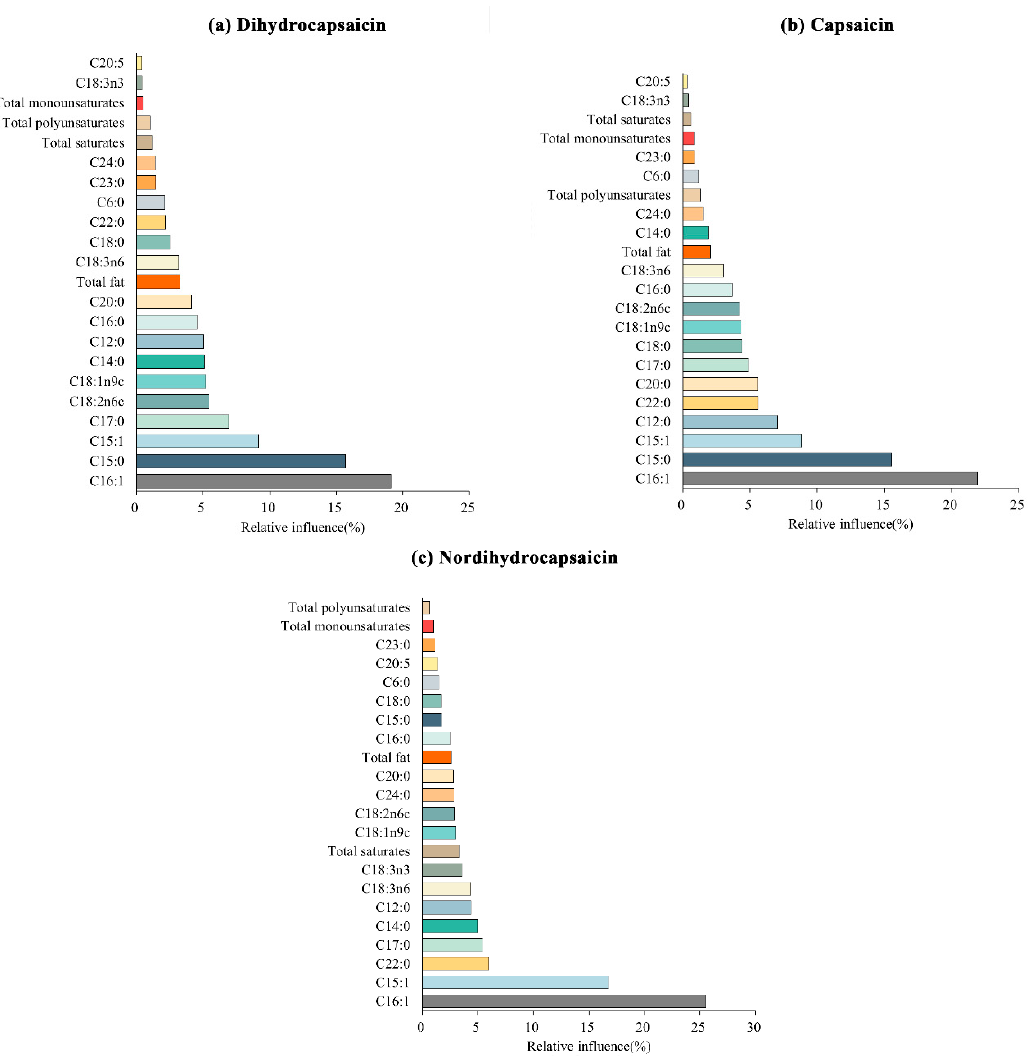
Figure 4. Aggregated boosted tree (ABT) reflecting the relative effect of fatty acid concentrations on the concentration and composition of capsaicinoids in pepper fruit.